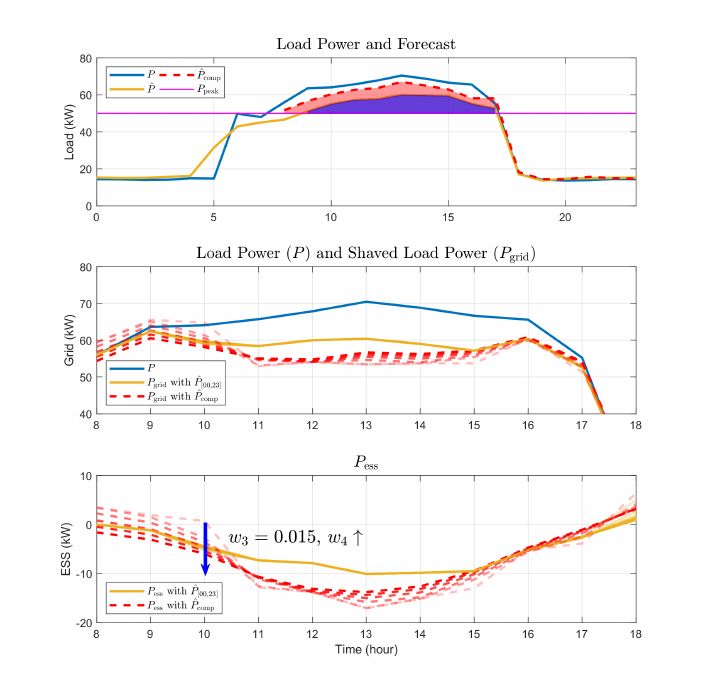
Figure 19. Effect of Weights w 4 on the Charging and Discharging